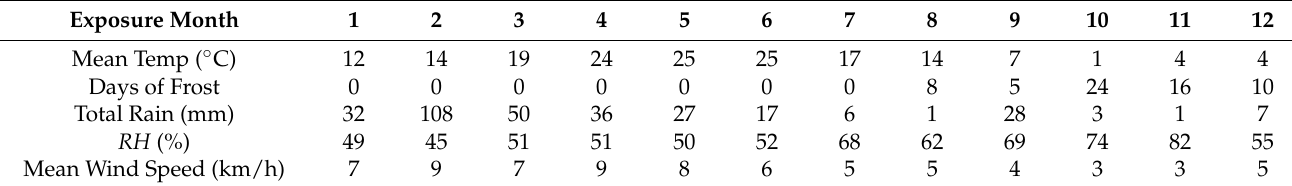
Table 1. Weather data (average values) acquired during weathering